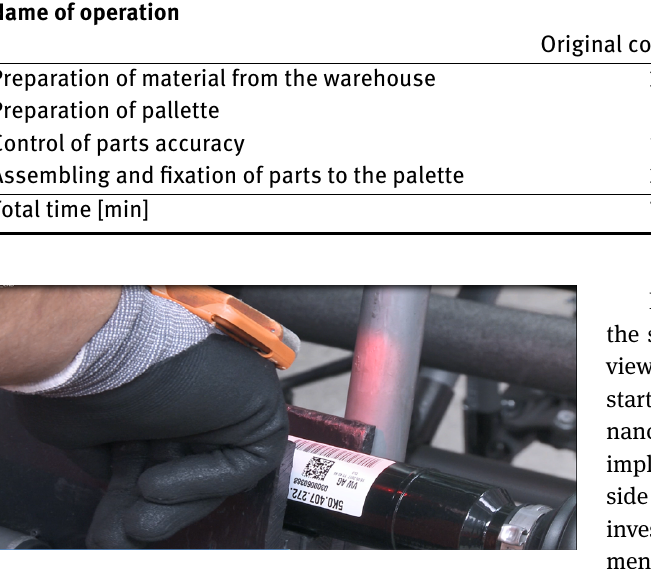
Figure 6: The download of material code.